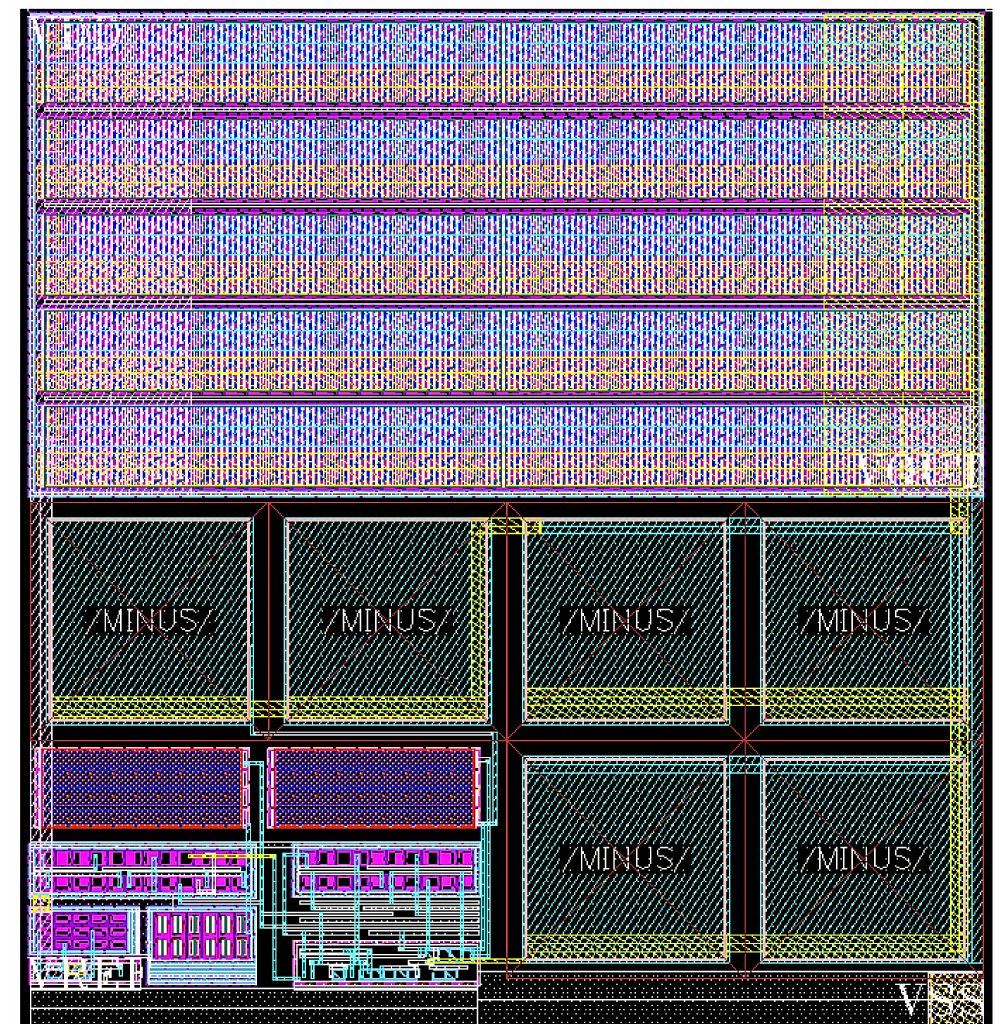
Figure 10. Layout of the proposed OCL–LDO.